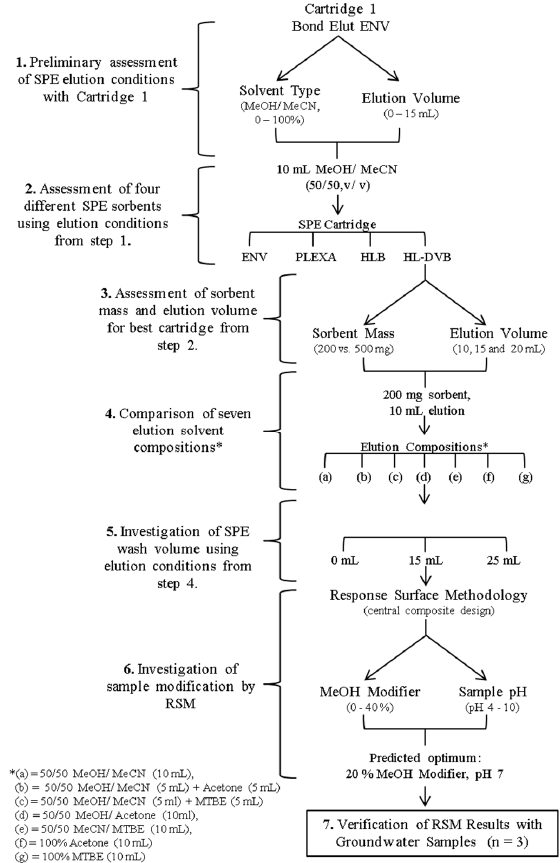
Figure 3. Summary of experimental conditions carried out for the response surface model.